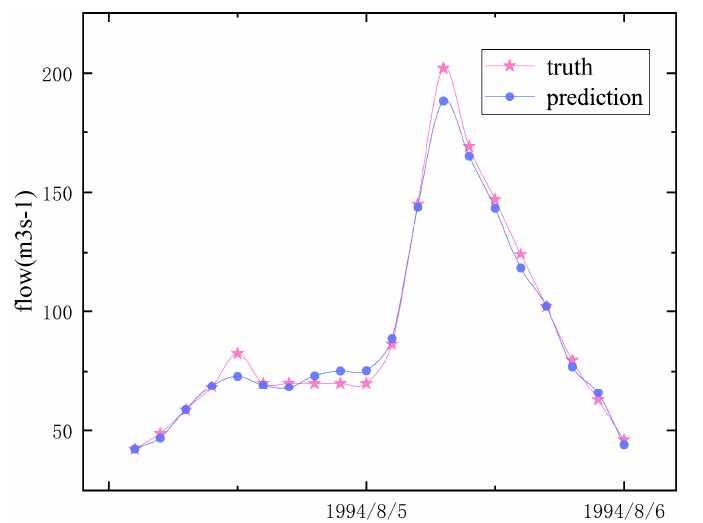
Figure 5. No. 19940806 MSBP model prediction. Pink is the true value, and blue is the predicted